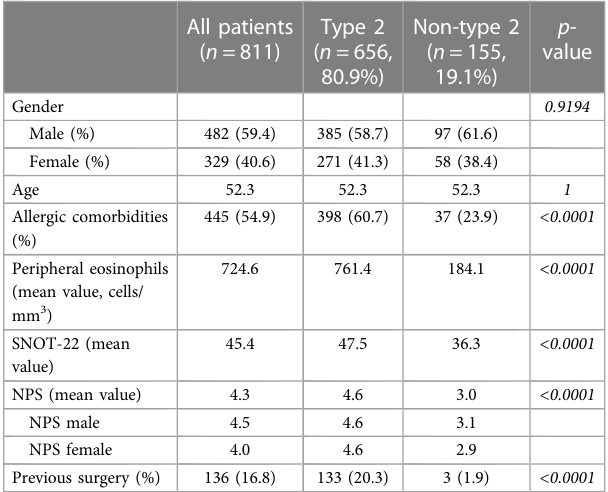
TABLE 1 A brief description of the population included in the study, divided in the two groups (type 2/non-type 2).